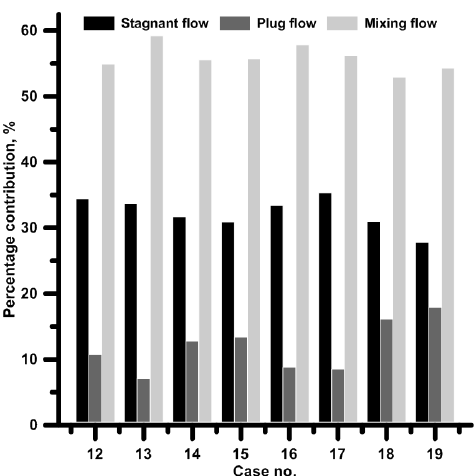
Figure 5. Hydrodynamic conditions for considered tundish variants with steady position of subflux turbulence controller.